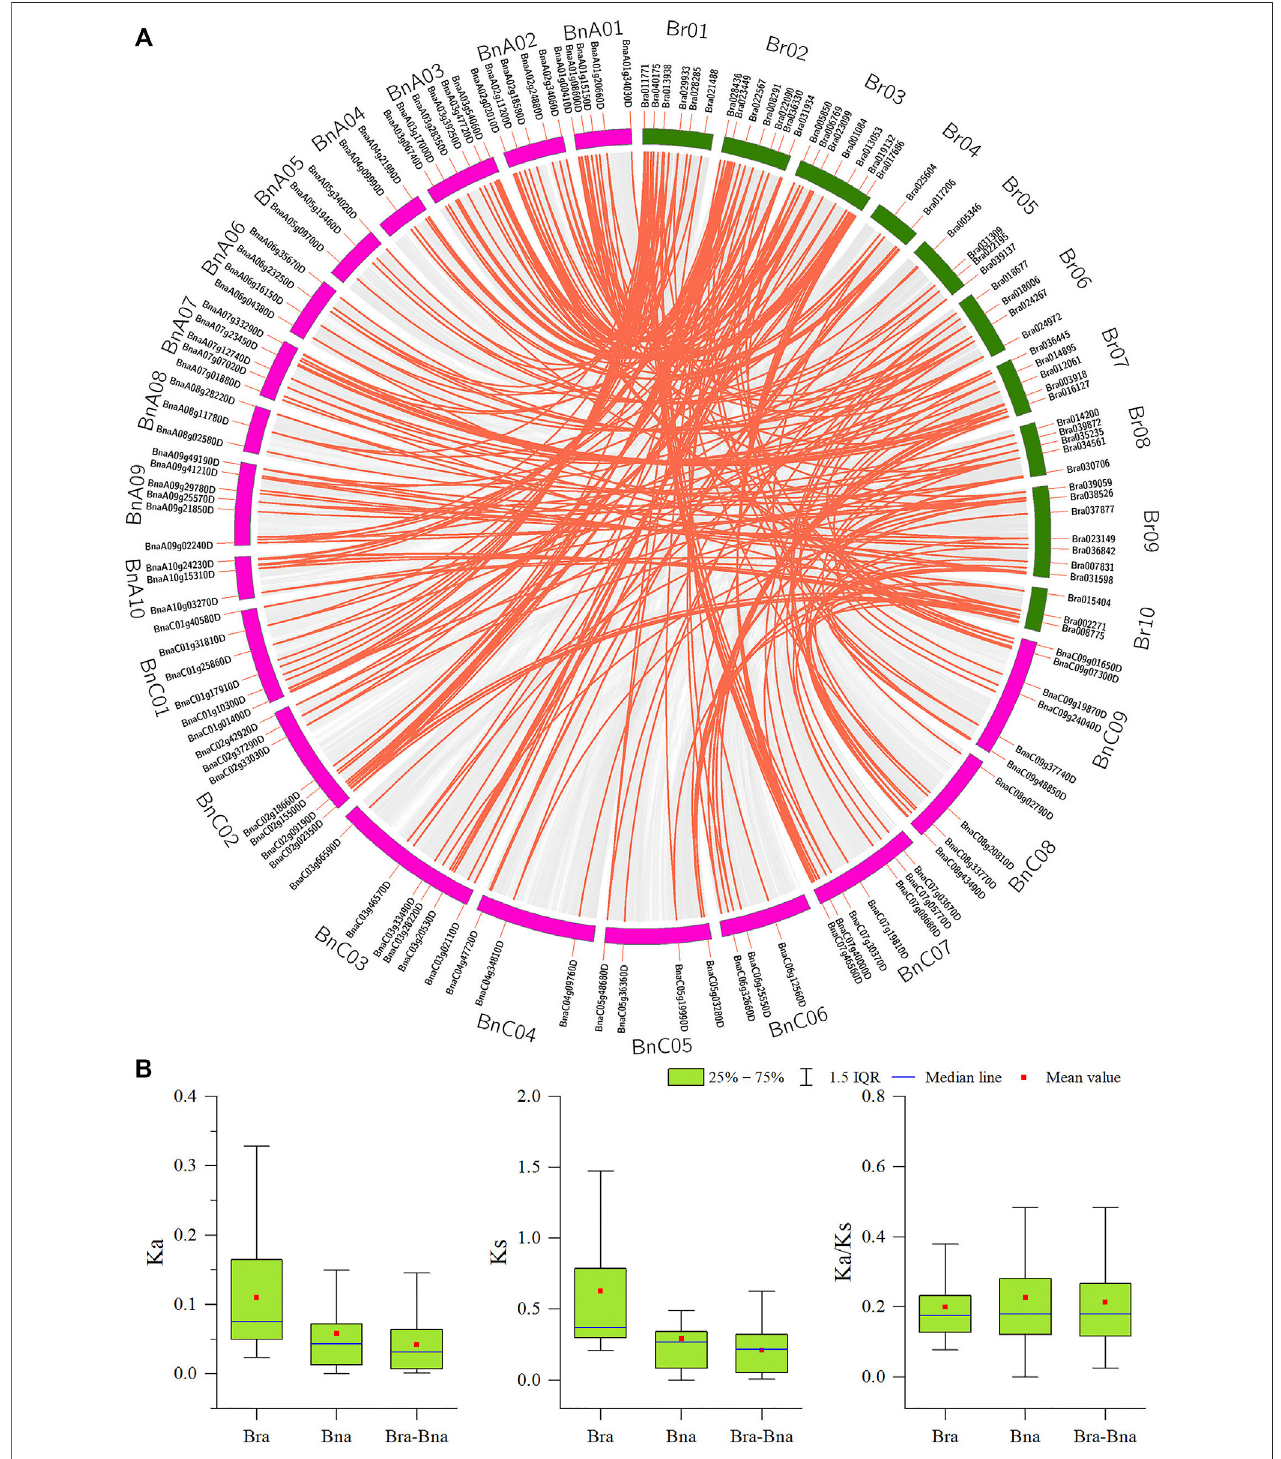
FIGURE5| Analysisoforthologousrelationshipsbetween APX genepairsin B.rapa and B.napus . (A) Circosplotof APX geneorthologsintwospecies. (B) Ka,Ks and Ka/Ks values for homozygous APX gene pairs between two species. Chromosomes of B. rapa and B. napus are represented by green and pink bars respectively; The gene number and chromosome label are next to the corresponding chromosome. The red curved lines indicate APX genes with collinearity.